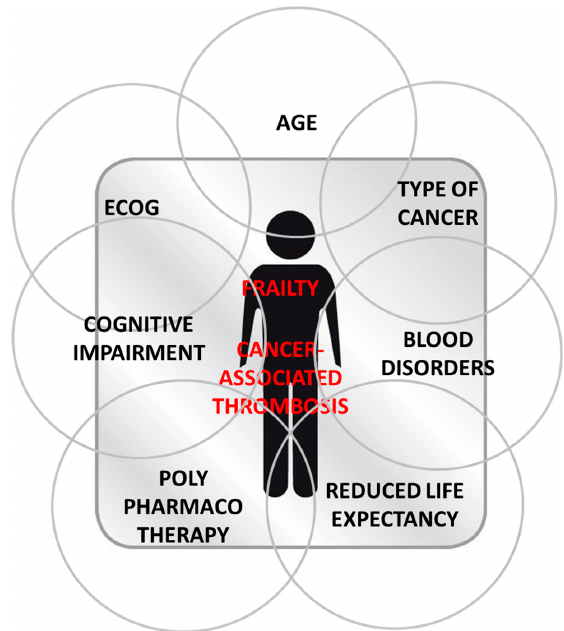
Figure 2. Complex interaction and overlapping factors contributing to frailty in patients with cancer-associated thrombosis.